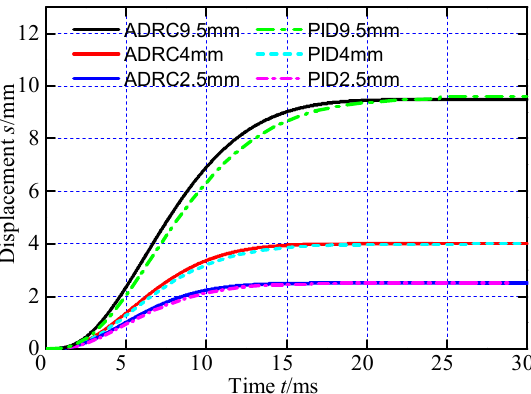
Figure 12. Comparison of displacement control.